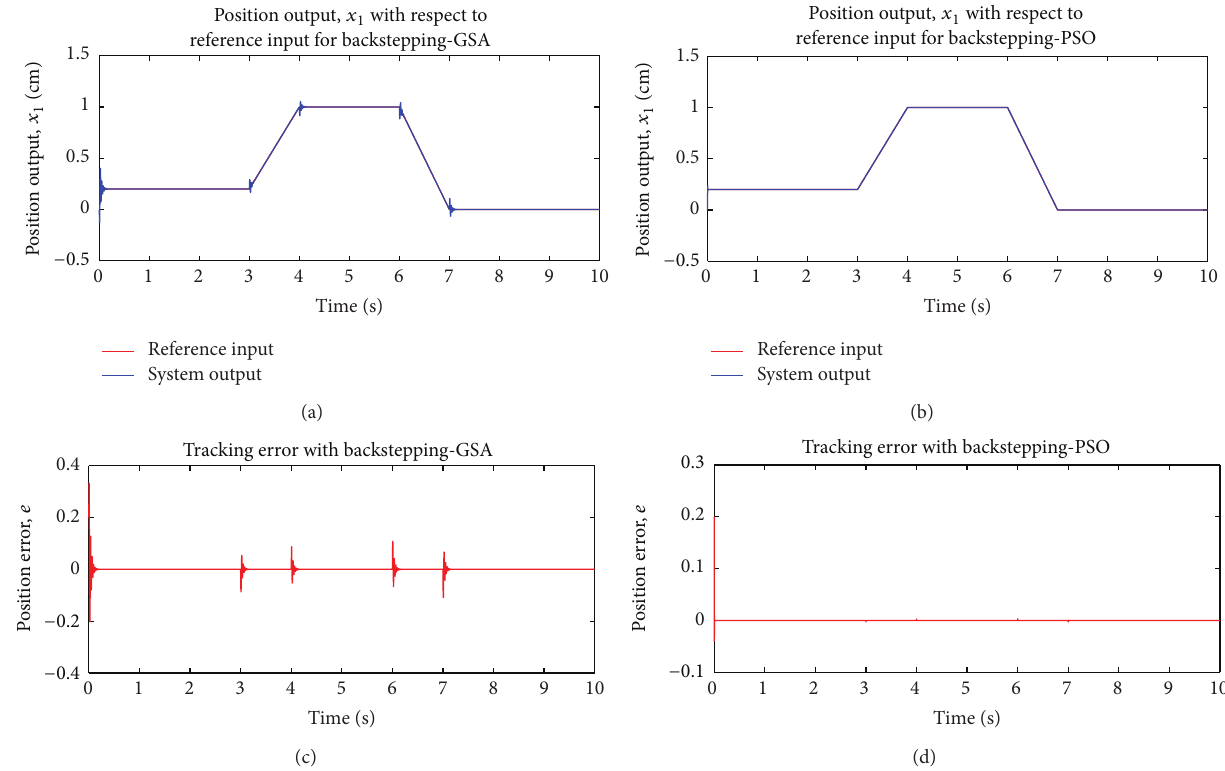
Figure2:Positionoutputwithrespecttoreferenceinputgivenandtrackingerrorforbackstepping-PSOandbackstepping-GSAwithconstant disturbance injected to the